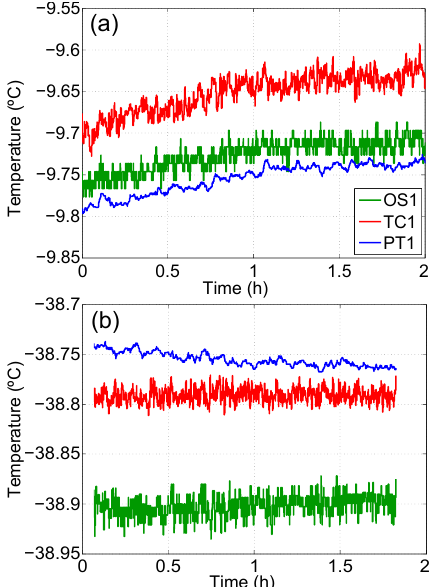
Figure 3. Examples of the typical temperature stability in the CLOUD chamber over a period of several hours: (a) during an ex- perimental data run and (b) during a calibration run (OS, optical sensor; TC, thermocouple, TC; and PT, Pt100 sensor). The tempera- ture drift in panel (a) can result from setting new experimental con- ditions such as the addition of ultraviolet radiation or trace gases, which causes a slight change in equilibrium temperature. The mea- surements are smoothed with a 5s fixed median window to reduce point-to-point scatter.